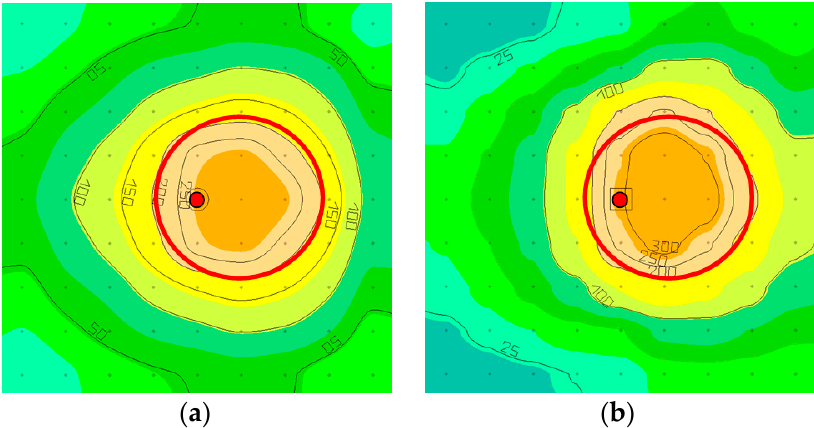
Figure 26. Illuminance distribution on a plane for narrow symmetrical distribution (76°): ( a ) results for a simulation model, ( b ) results for a prototype luminaire.